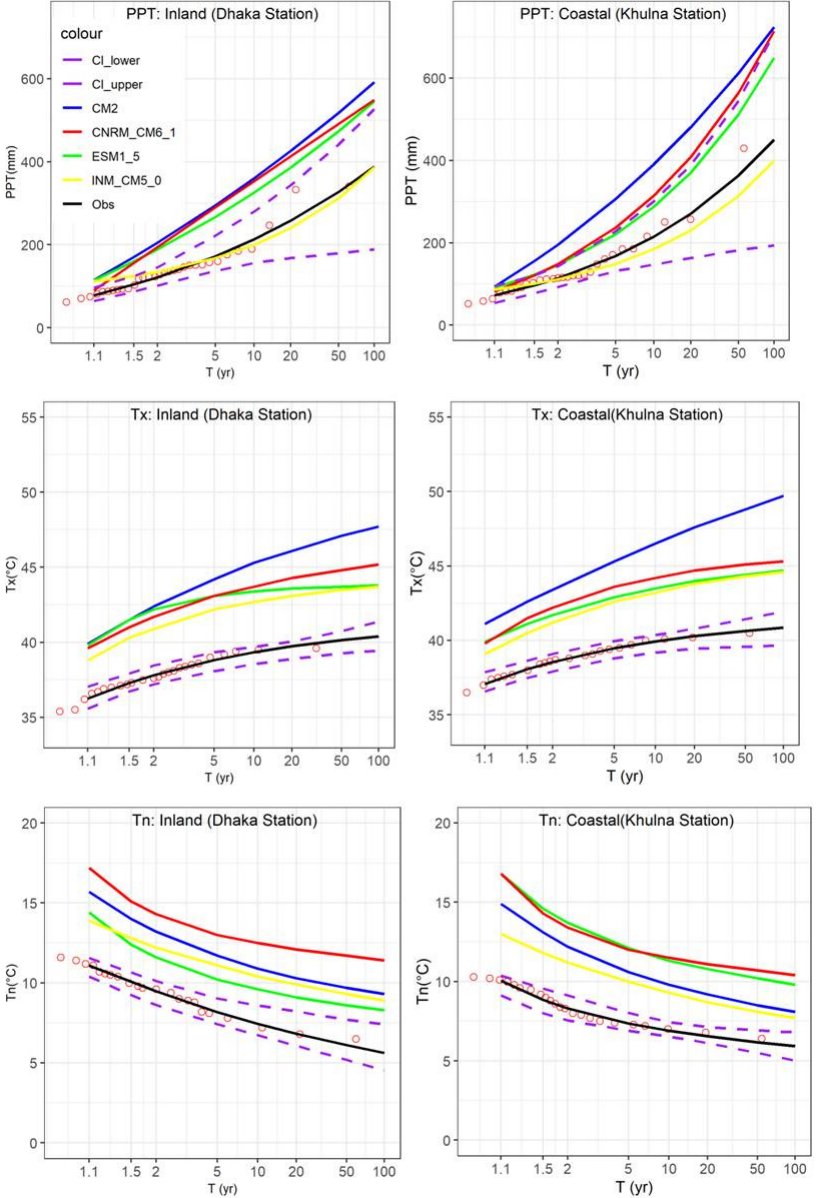
Figure 7. Examination of probability plots of climate extremes (PPT, Tx and Tn) at observed and future conditions (4 GCMs under SSP585 in the far future) for the selected coastal and inland stations. The y axis represents return period (T) in years.